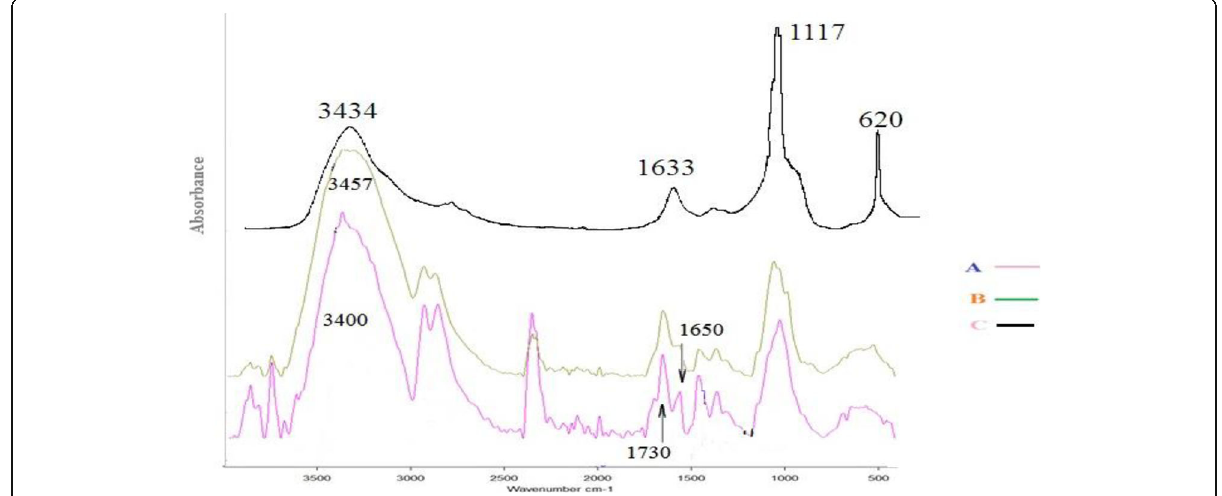
Fig. 9 FT-IR of activated beads (Ch-MNP/PEI/GA) (A), immobilized enzyme (Ch-MNP/PEI/GA/Enz) (B) and free enzyme